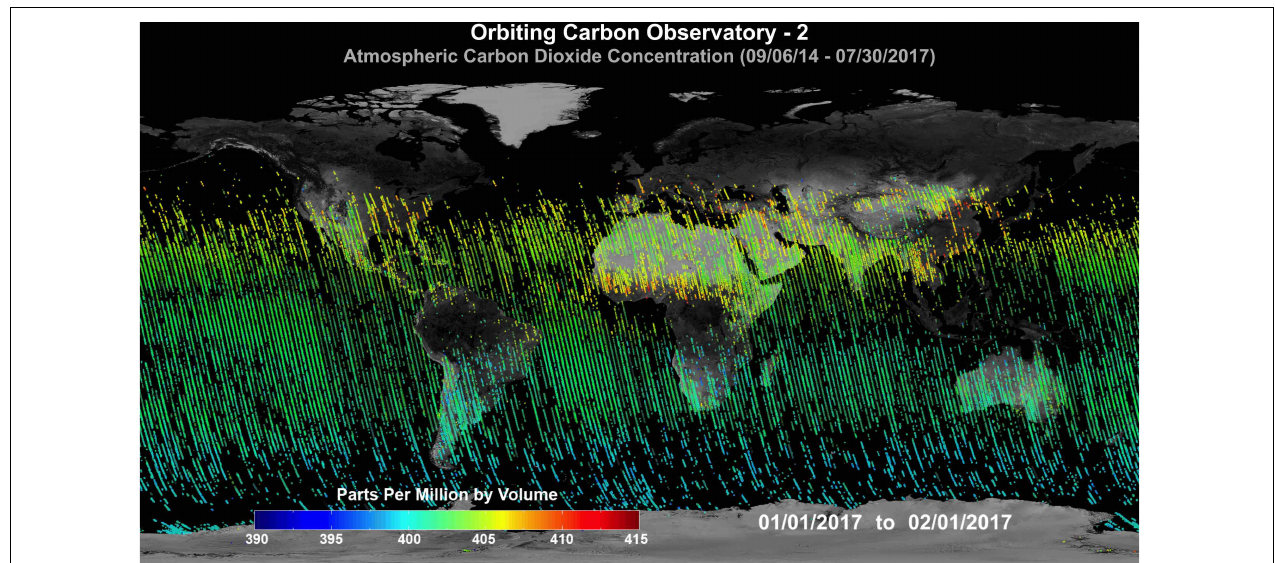
FIGURE 8 | Column xCO 2 measurement from the Observations from the Orbiting Carbon Observatory-2 (OCO-2) for January 2017. These data were produced by the OCO-2 project at the Jet Propulsion Laboratory, California Institute of Technology, and obtained from the OCO-2 data archive maintained at the NASA Goddard Earth Science Data and Information Services